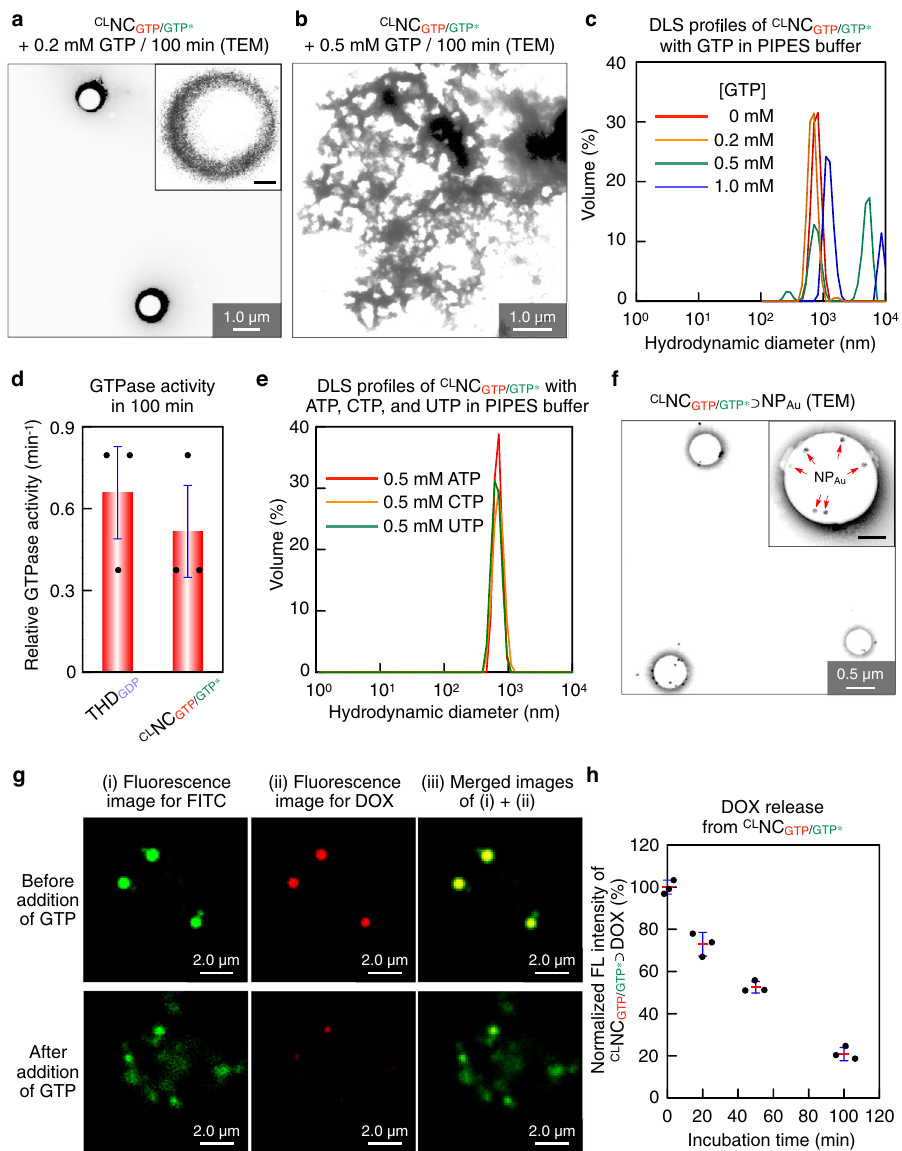
Fig. 4 | GTP-triggered collapseof CL NC GTP/GTP* . a , b TEM images of CL NC GTP/GTP* after a 100-min incubation withGTP atits concentrations of0.2mM ( a ) and 0.5mM ( b ). c DLS pro fi les of CL NC GTP/GTP* (8.7 µ gml – 1 ) in PIPES buffer after a 100-min incubation with GTP at its concentrations of 0mM (red), 0.2mM (orange), 0.5mM (green), and 1mM(blue). d GTPaseactivitiesofTHD GDP (left)and CL NC GTP/GTP* (right)inPIPESbuffer.Thedatawasobtainedfromthreebiologicallyindependentsamples( n =3). e DLS pro fi les of CL NC GTP/GTP* (8.7 µ gml – 1 ) in PIPES buffer after a 100-min incubation with 1mM of ATP (red), CTP (orange), and UTP (green). f TEM image of CL NC GTP/GTP* ⊃ NP Au ([ CL NC GTP/GTP* ]=13 µ gml – 1 , [NP Au ]=13pM). g CLSMimagesofFITC-labeled CL NC GTP/GTP* ⊃ DOX ([ CL NC GTP/GTP* ]=13 µ gml – 1 , [DOX]=10 µ M)incubatedwithout (upper panel) and with (lower panel) 1mMGTPat37°Cfor 100min. Micrographs display locations of FITC(i, green)and DOX(ii, red),and their merged images (iii). Scale bars, 2.0 µ